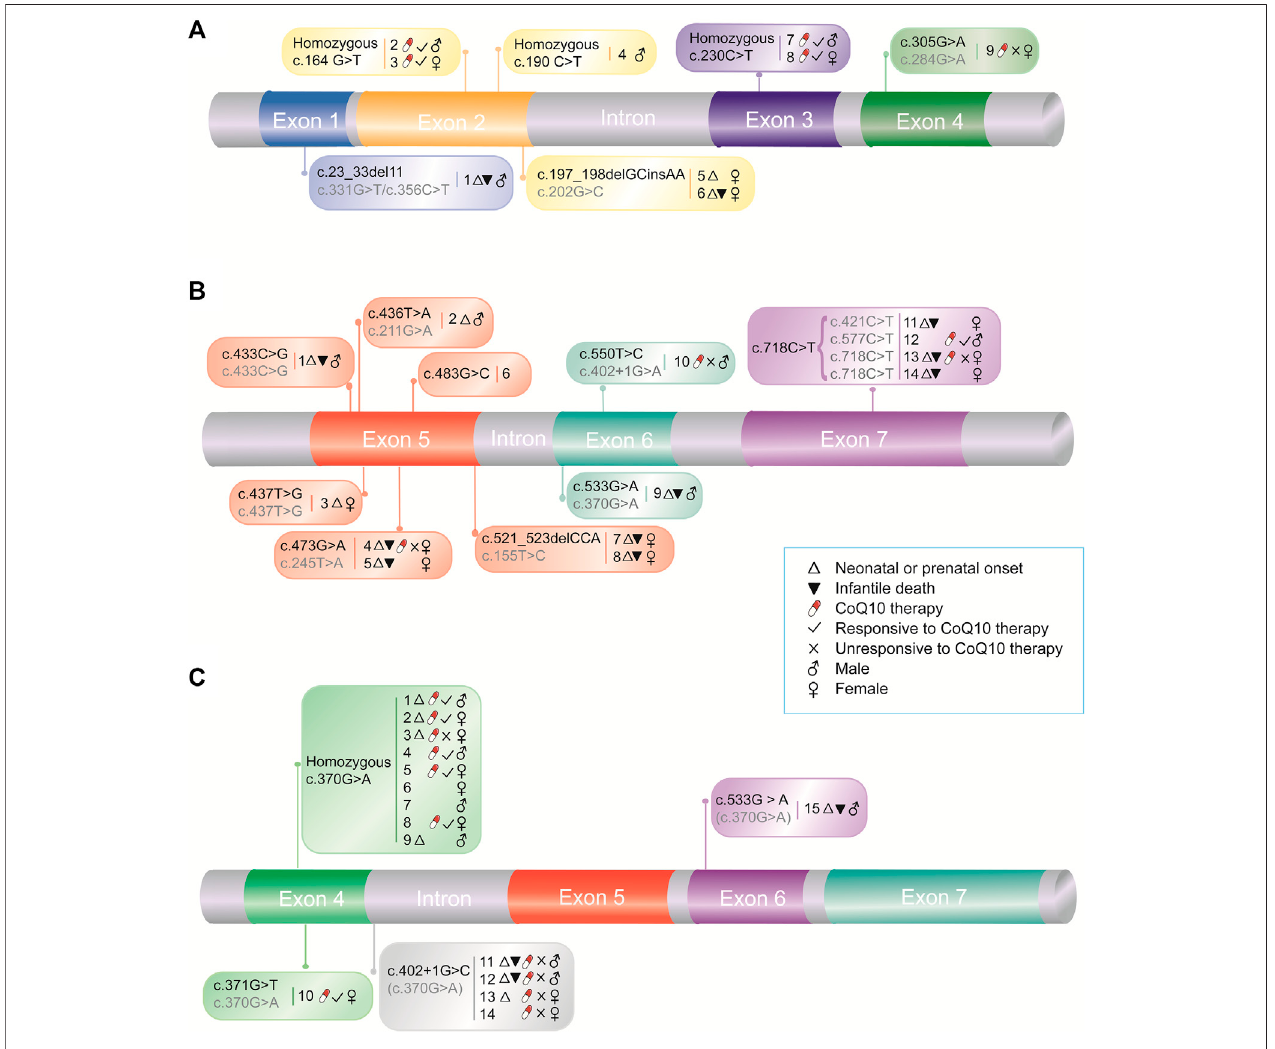
FIGURE 1 | Pathogenic COQ4 variantsand associated medical information. Medicalinformation for patientswith COQ4 variantsinexons 1 – 4 (A) and exons 5 – 7 (B) , and with East Asian-speci fi c c.370G > A variant (C) , respectively. The numbers indicate case numbers in Tables 1 , 2 , and 3 . The second alleles were indicated in grey.